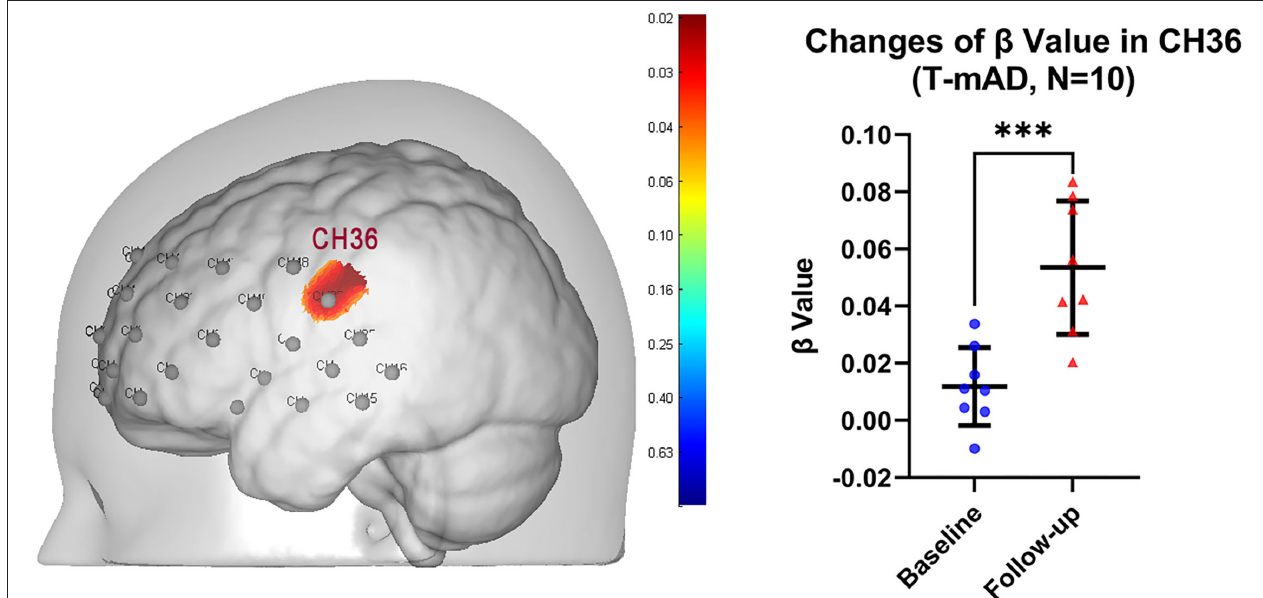
FIGURE 5 | Change of brain activation after intervention in T-mAD subjects. CH36 area was significantly activated after sport stacking intervention (left) and statistical results (right). *** p < 0.001. Each dot represents the individual β value of T-mAD participants in CH36 at baseline and at follow-up. No significant brain activation differences in T-MCI subjects were found, and no significant differences between intervention groups and control groups were